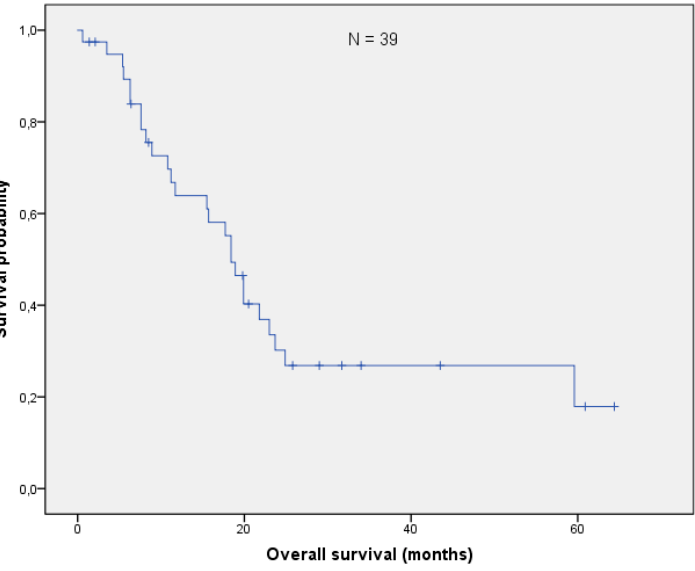
Figure 1. The median overall survival in the whole cohort (N = 39) was 18.4 months (95% CI: 16.0–20.8).